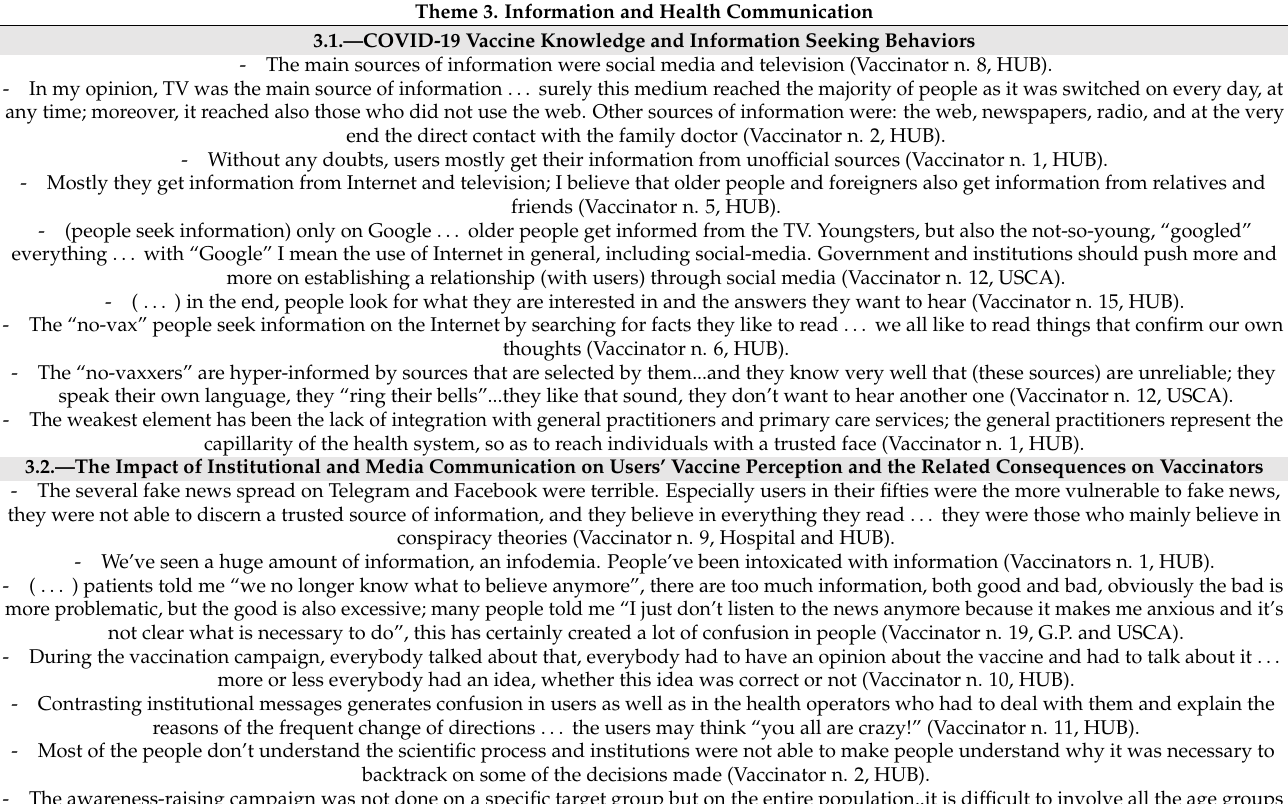
Table 5. Illustrative quotes for theme 3, “information and health